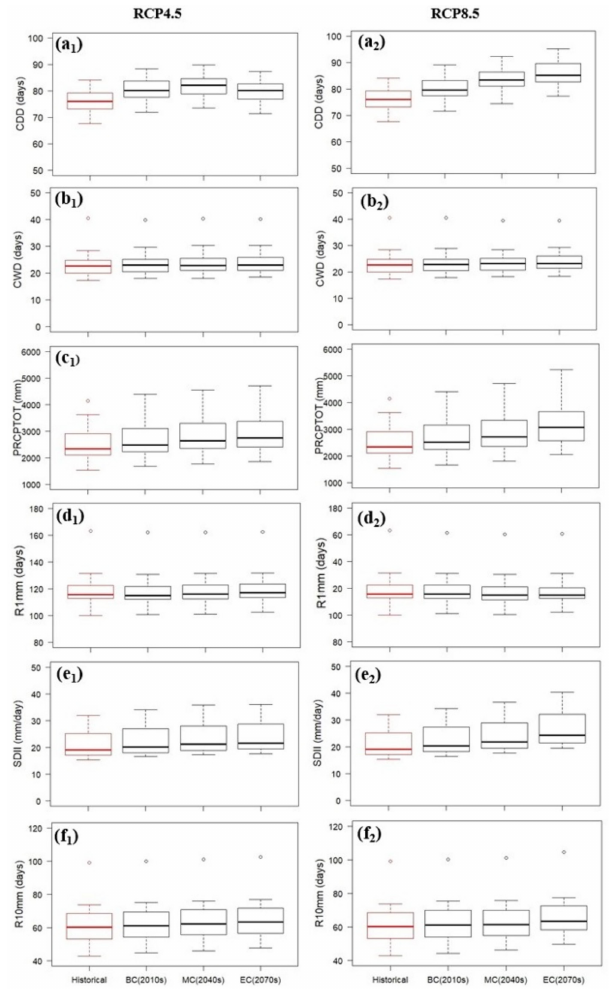
Figure 6. Future changes of climate indices under RCP4.5 (left) and RCP8.5 (right); ( a ) CDD, ( b ) CWD, ( c ) PRCPTOT, ( d ) R1mm, ( e ) SDII, and ( f )